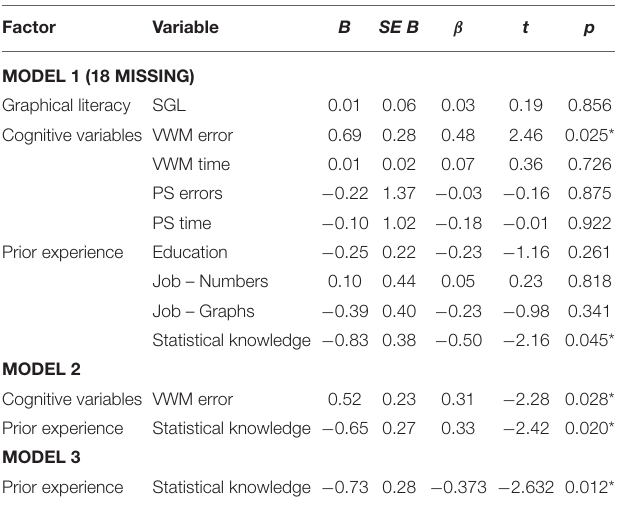
TABLE 1 | Study 2: multiple regression models to predict the general understanding of visualizations in the expert